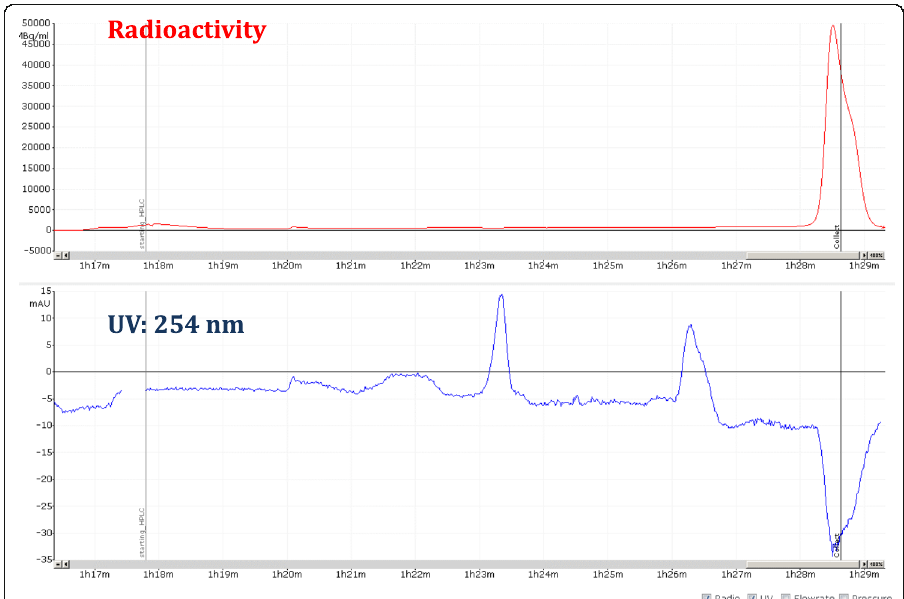
Fig. 9 A view of typical semi-preparative chromatogram of [ 18